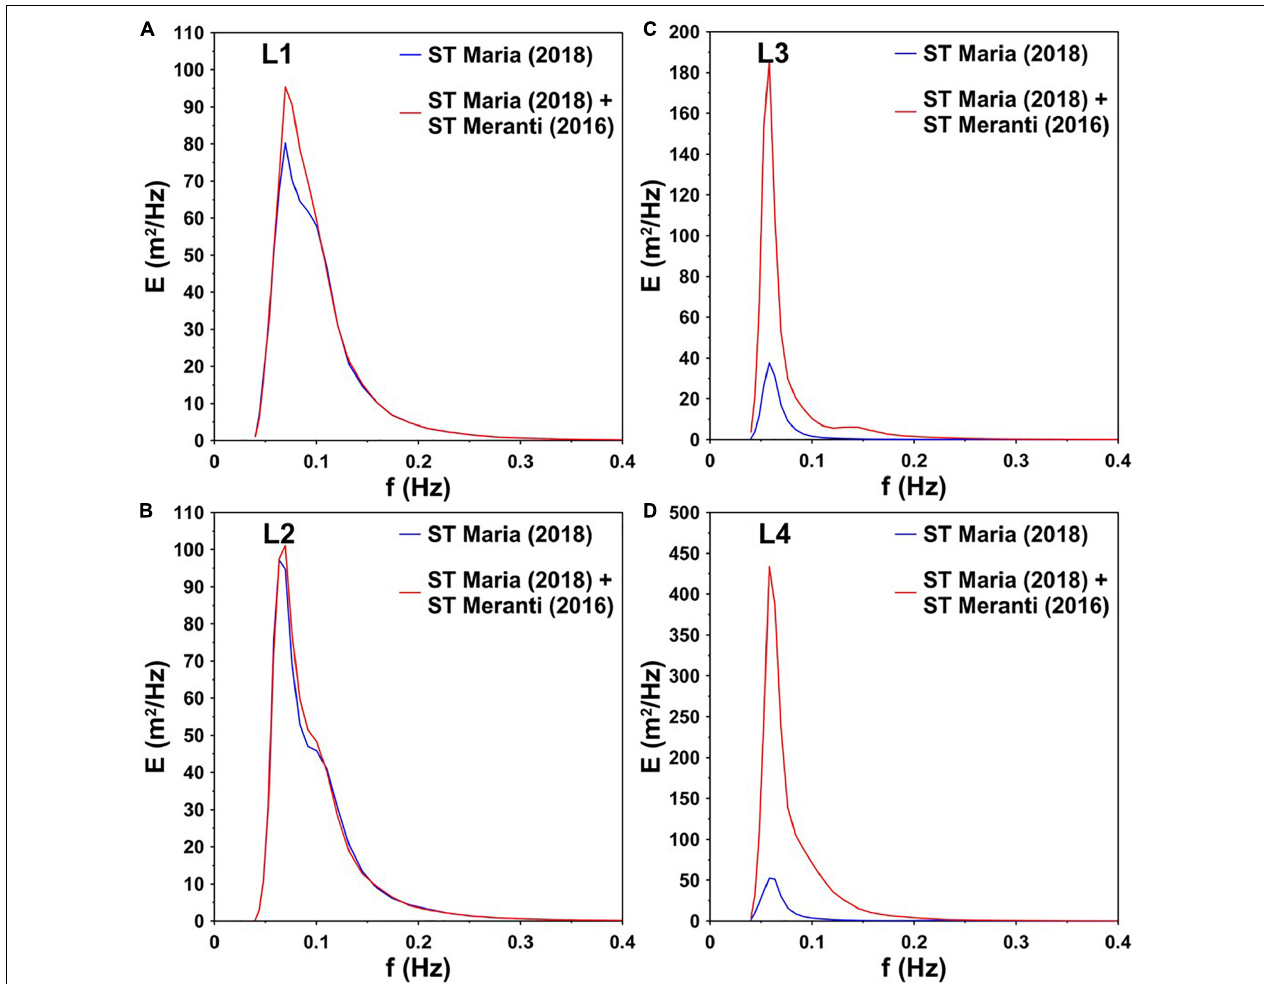
FIGURE 10 | Comparison of 1-D wave energy spectra time series generated by Super Typhoon Maria in 2018 and designed binary typhoons Maria (2018) and Meranti (2016) at (A) L1, (B) L2, (C) L3, and (D) L4 four selected representative points at the time of the peak significant wave during single Super Typhoon Maria